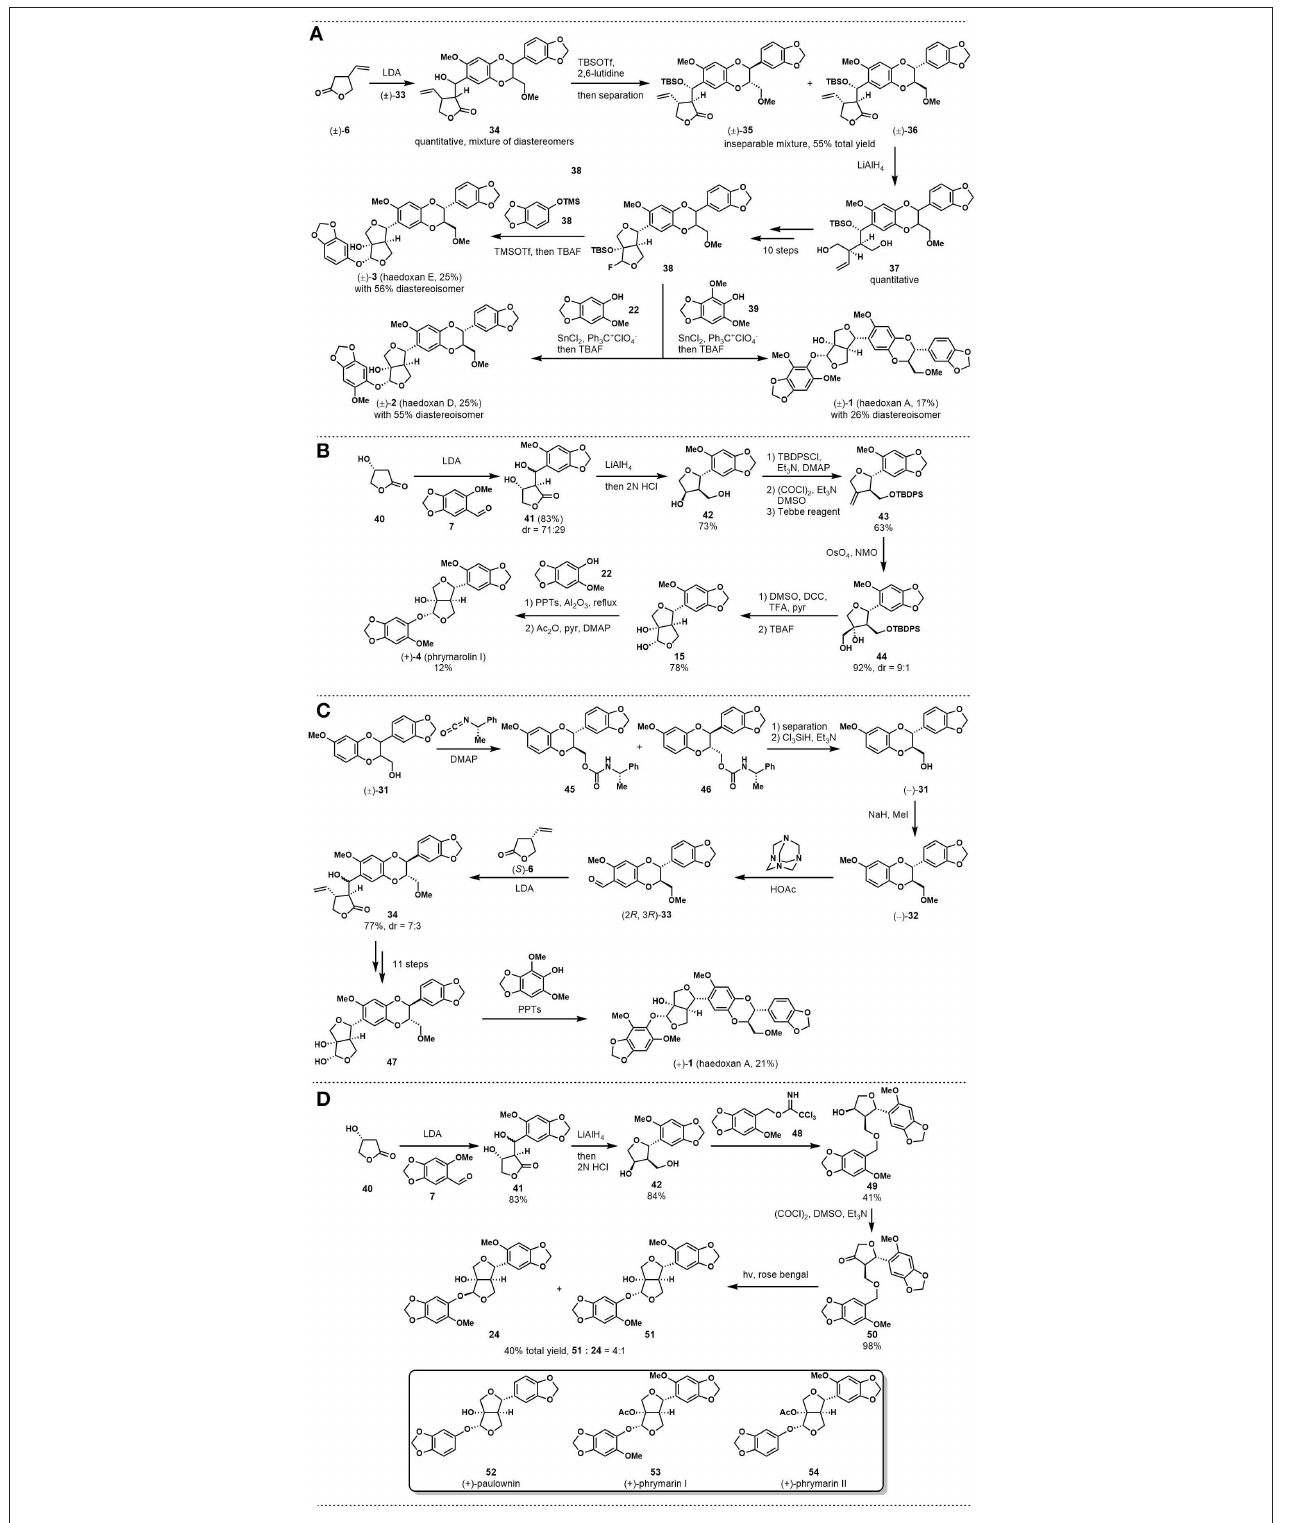
FIGURE 2 | (A) Ishibashi and Taniguchi’s total synthesis of ( ± )-haedoxan A, D, and E; (B) Taniguchi and Ishibashi’s asymmetric synthesis of ( + )-phrymarolin I; (C) Ishibashi and Taniguchi’s asymmetric synthesis of ( + )-haedoxan A; (D) Ishibashi’s concise synthesis of ( + )-paulownin, ( + )-phrymarin I, and ( + )-phrymarin II.